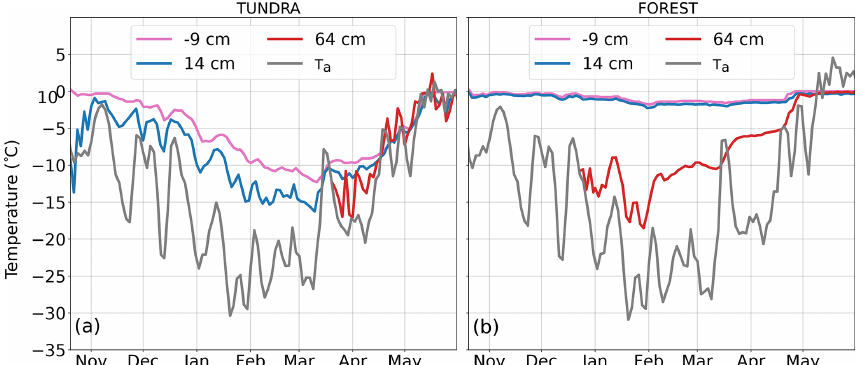
Figure 8. Snow (blue and red lines), ground (pink line), and air temperatures (grey line) at (a) TUNDRA and (b) FOREST for winter 2018– 2019. Heights at which measurements were taken are relative to the ground surface. Air temperature T a was measured at 2.3m above ground. The values correspond to measurements collected once every other day at 05:00EST.